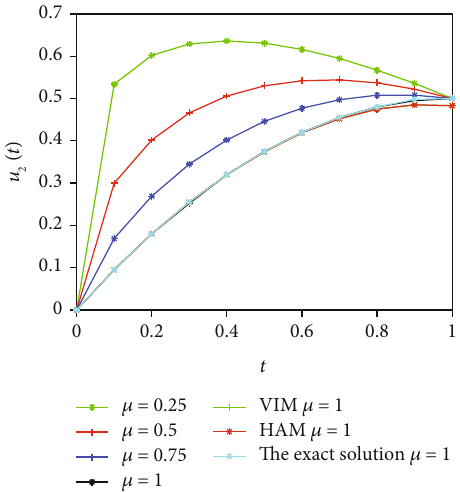
Figure 28: The numerical solution of u Example 3 in Ref. [4].